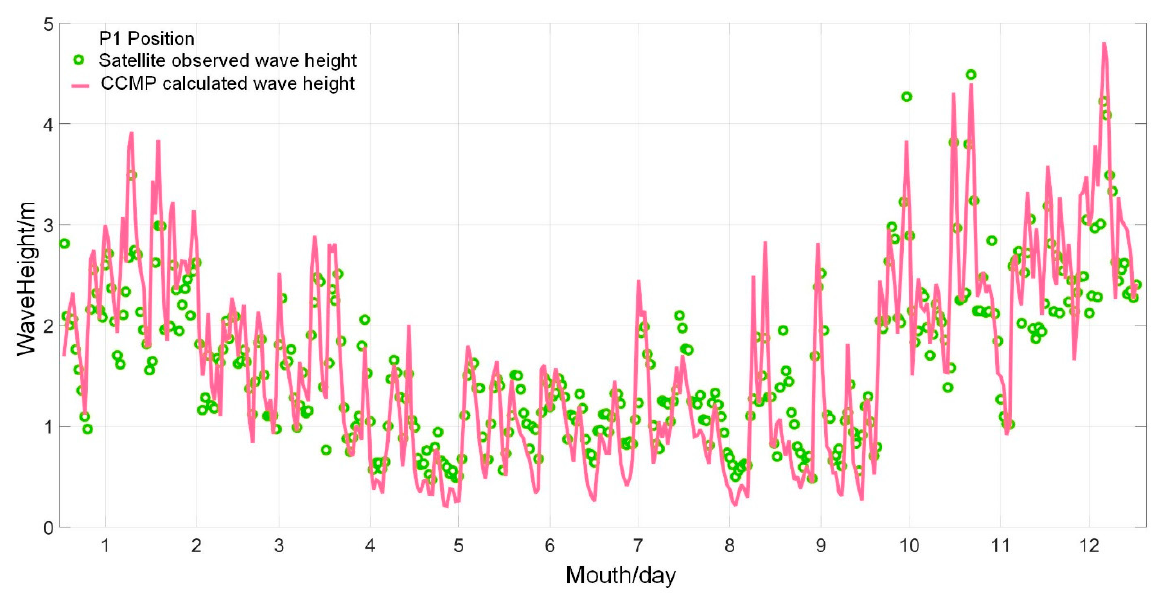
Figure 2. Observed and calculated wave height variation trend at the P1 position. The pink line represents the simulated wave height of the CCMP wind field, and the green dotted line represents the observed data of the altimeter.